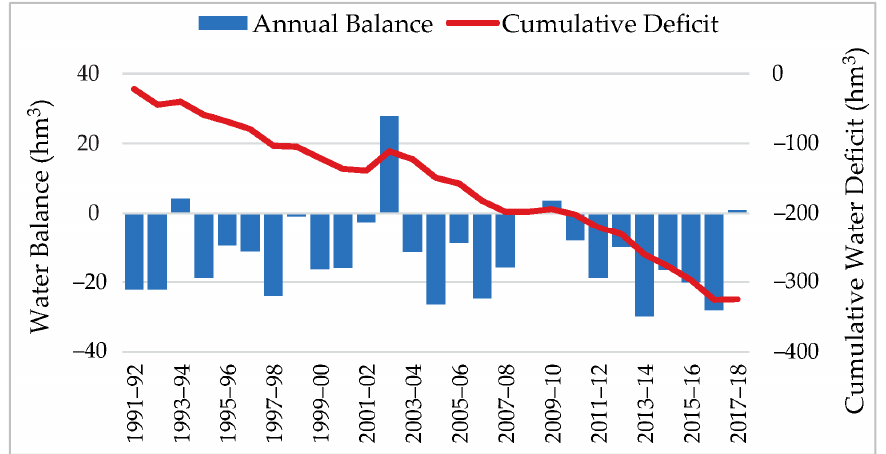
Figure 25. Annual water balance and cumulative water deficit for the simulation years 1991–2018.